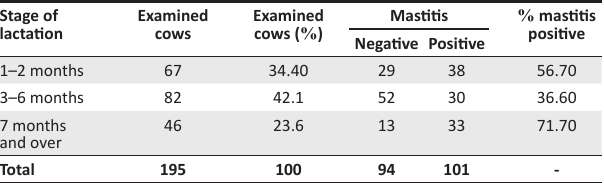
TABLE 7: Mastitis prevalence in different stages of